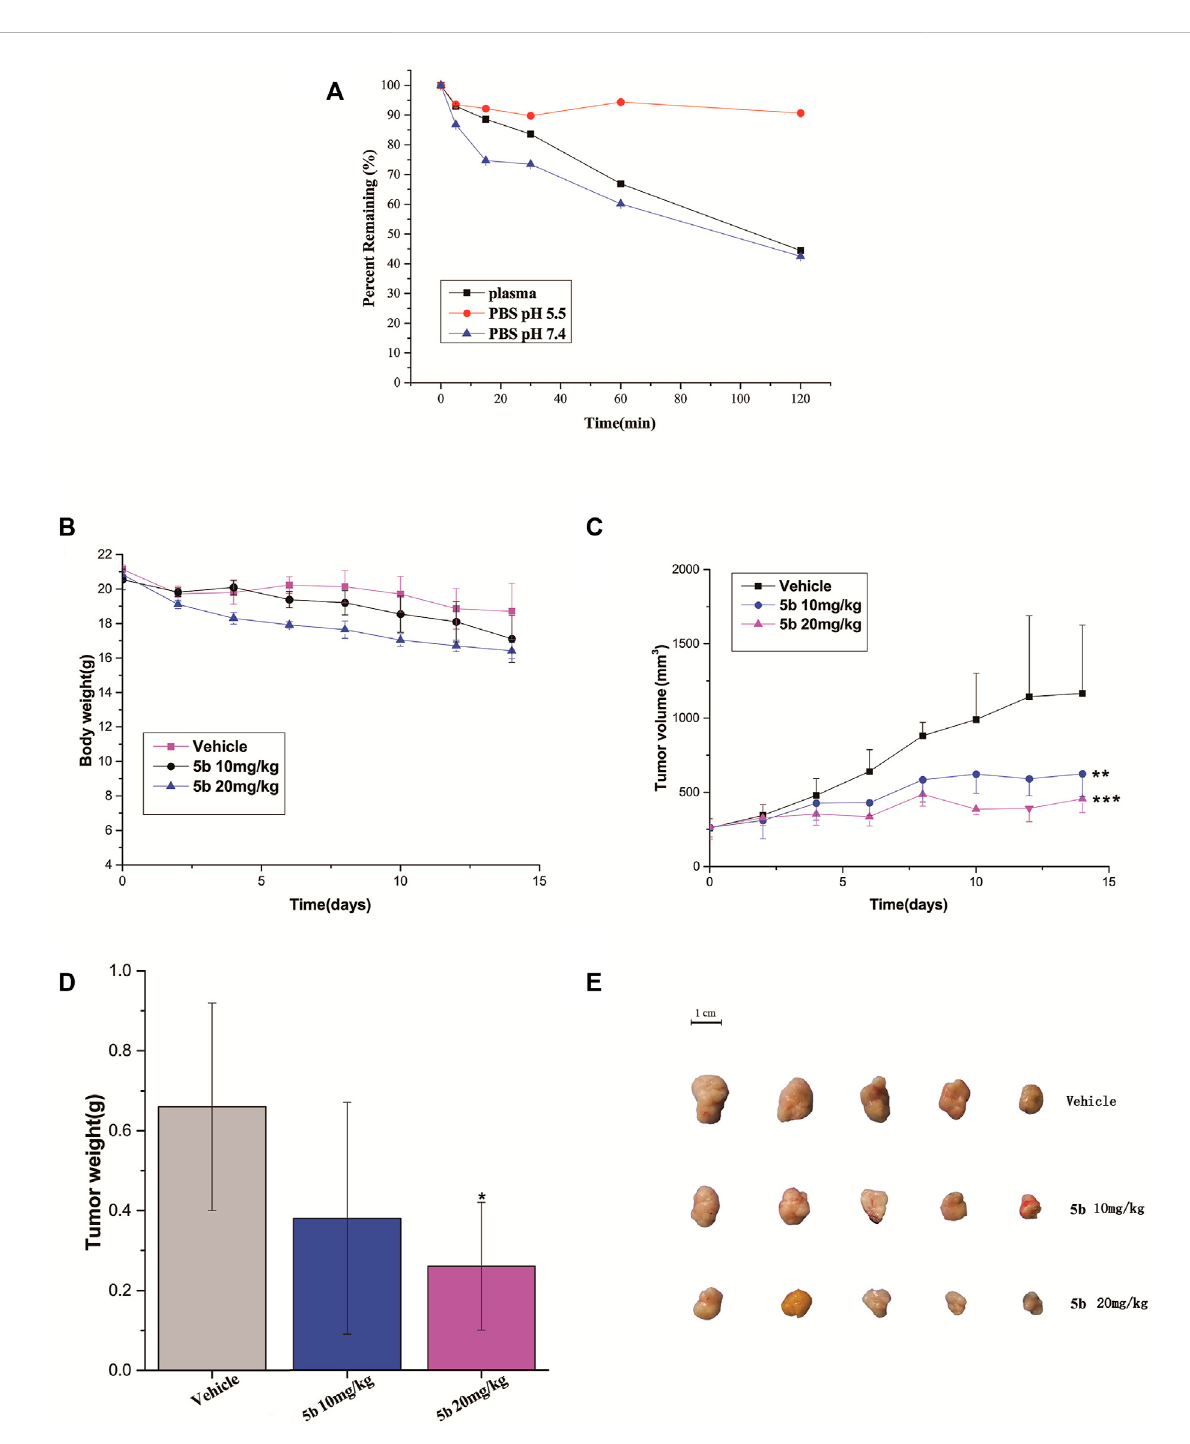
FIGURE 4 (A) Stabilityof compound 5binPBS (pH5.5 andpH 7.4)and plasma. (B) Thebody weightofthemice during thetreatment. (C) Tumorgrowth of HCT116 model inhibited by 5b (** p < 0.01; *** p < 0.001). (D) Represented weight of tumors from mice of different groups, respectively. Data were mean ± S.D. ( n = 5, * p < 0.05). (E) Representative photographs of subcutaneous tumors in the HCT116